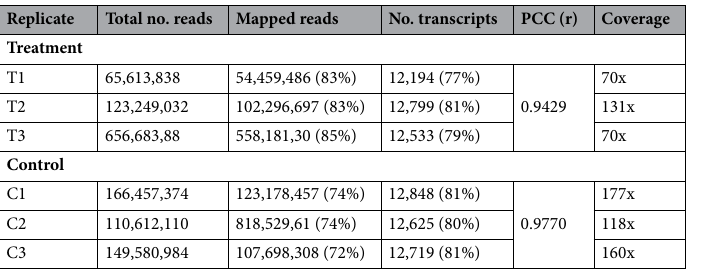
Table 2. Statistics of RNA sequencing for Plasmodium falciparum sporozoite infected treatment and naïve control Anopheles gambiae s.s. libraries. PCC denotes Pearson’s correlation coefficient.